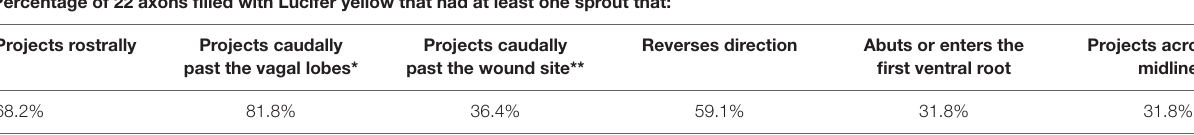
TABLE 1 | Projection patterns of Mauthner axon (M-axon) sprouts 56–85 days following spinomedullary level (SML)-crush. Percentage of 22 axons filled with Lucifer yellow that had at least one sprout that: Projects rostrally